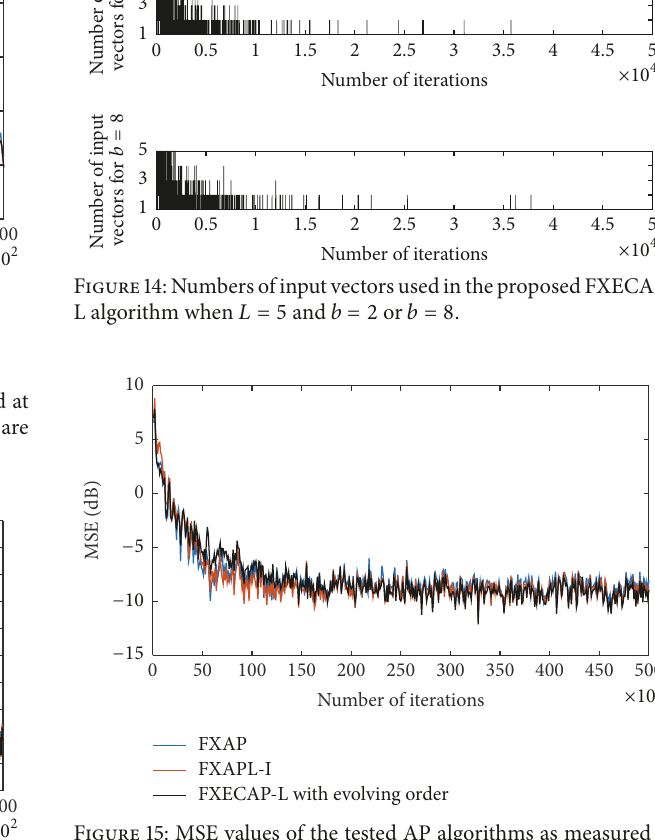
Figure 15: MSE values of the tested AP algorithms as measured at error sensor 1 for a projection order of 𝐿 = 10 when 𝑏 = 2 bits are used to encode the